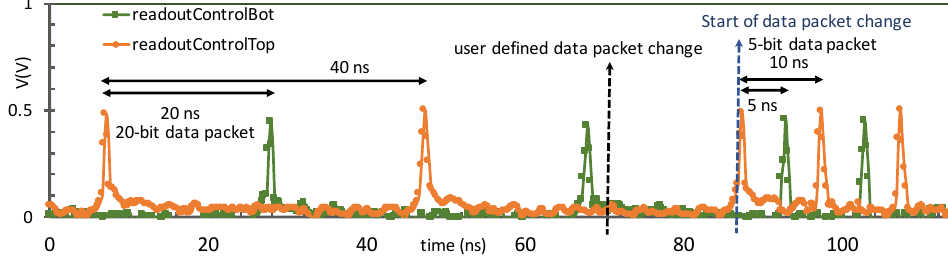
Figure 8. The DCT is operating at 1 GHz and a user defined data packet change to reduce the pixel data occurs in the middle of data transmission sequence. The output serializer finishes sending the current data packet completely before changing the data packet length from 20 bits to 5